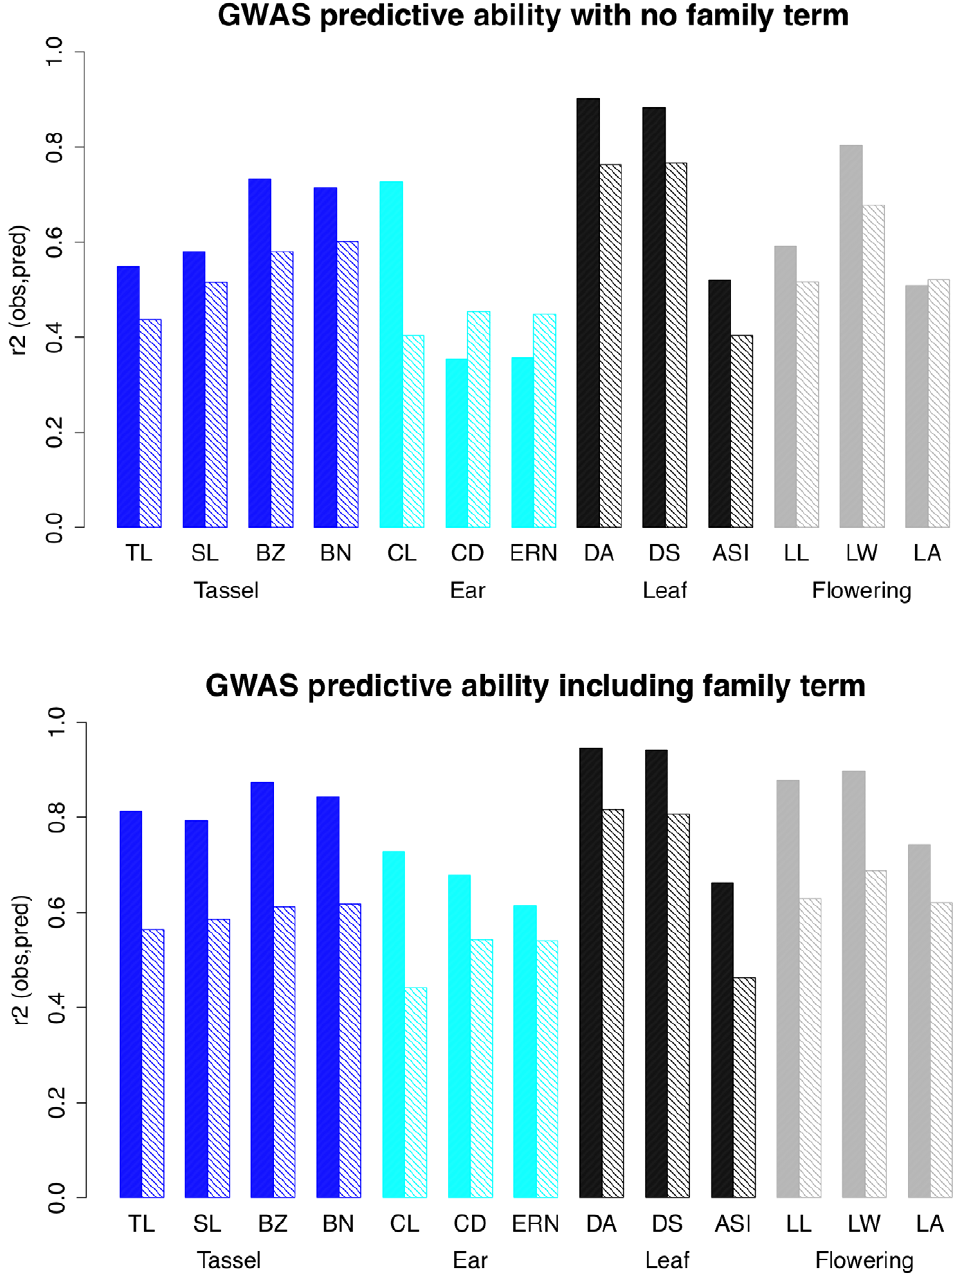
Figure 4. Predictive ability of GWAS models. The proportion of the phenotypic variance explained by GWAS models for 26 parental phenotypes (solid bars) and 4892 RIL phenotypes (hatched bars) in models without (top) and with (bottom) a family term. Trait categories are colored as in previous figures. TL=tassel length; SL=spike length; BZ=branch zone; BN=branch number; CL=cob length; CD=cob diameter; ERN=ear row number; DA=days to anthesis; DS=days to silking; ASI=anthesis-silking interval; LL=leaf length; LW=leaf width; LA=leaf